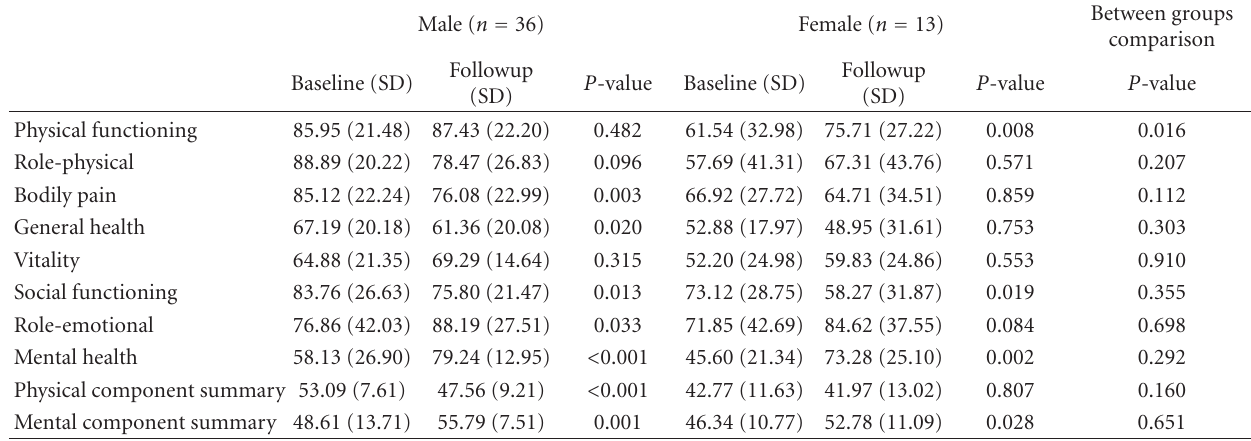
Table 4: The HRQoL scores at the first and third year post-treatment in based on gender.